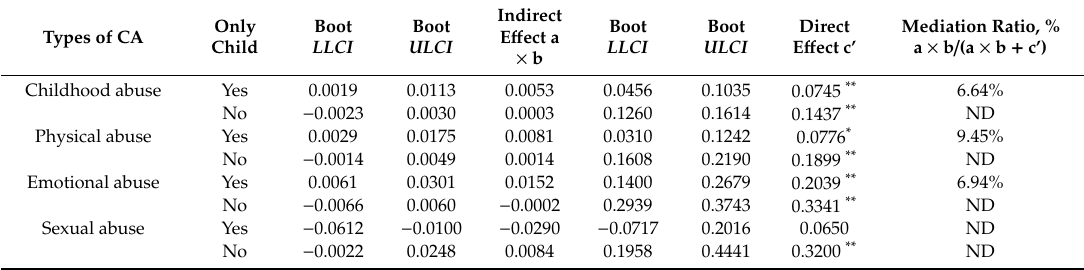
Table A1. Childhood abuse - social support from classmates and friends - NSSI.